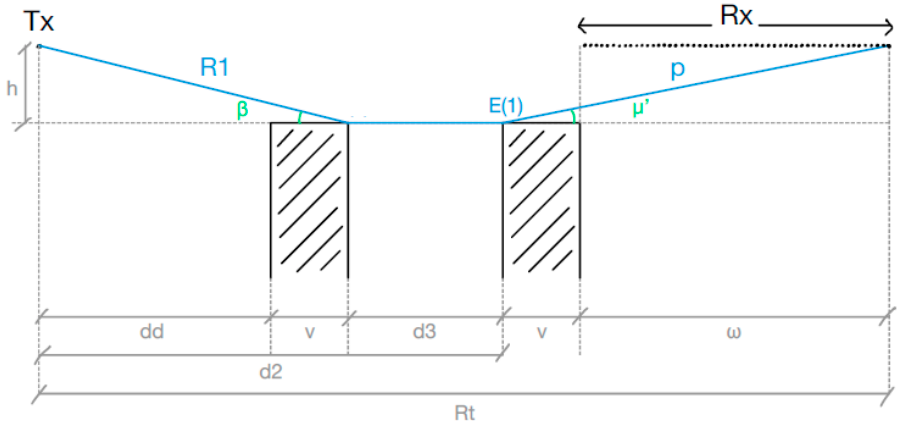
Figure 8. Second double diffraction (Edif_d2) of the considered LOS scenario.